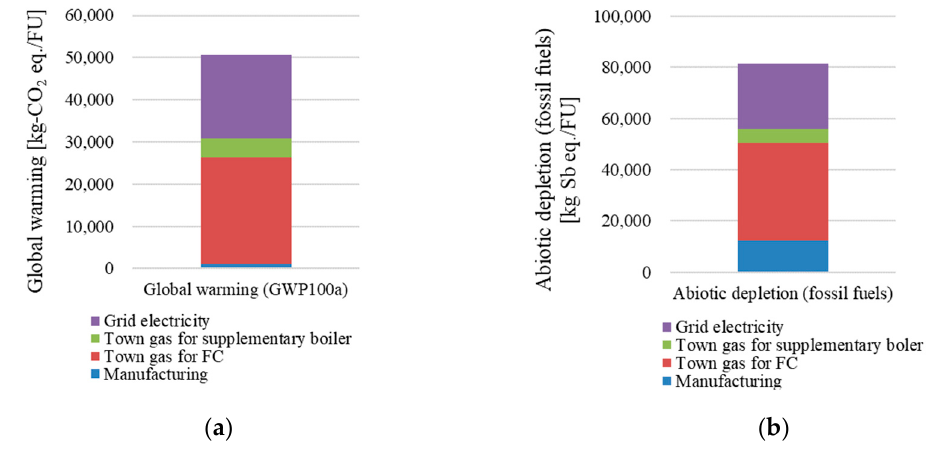
Figure 12. ( a ) Results of GWP in the manufacturing and utilization stage; ( b ) results of ADP (fossil fuels) in the manufacturing and utilization stage. fuels) in the manufacturing and utilization